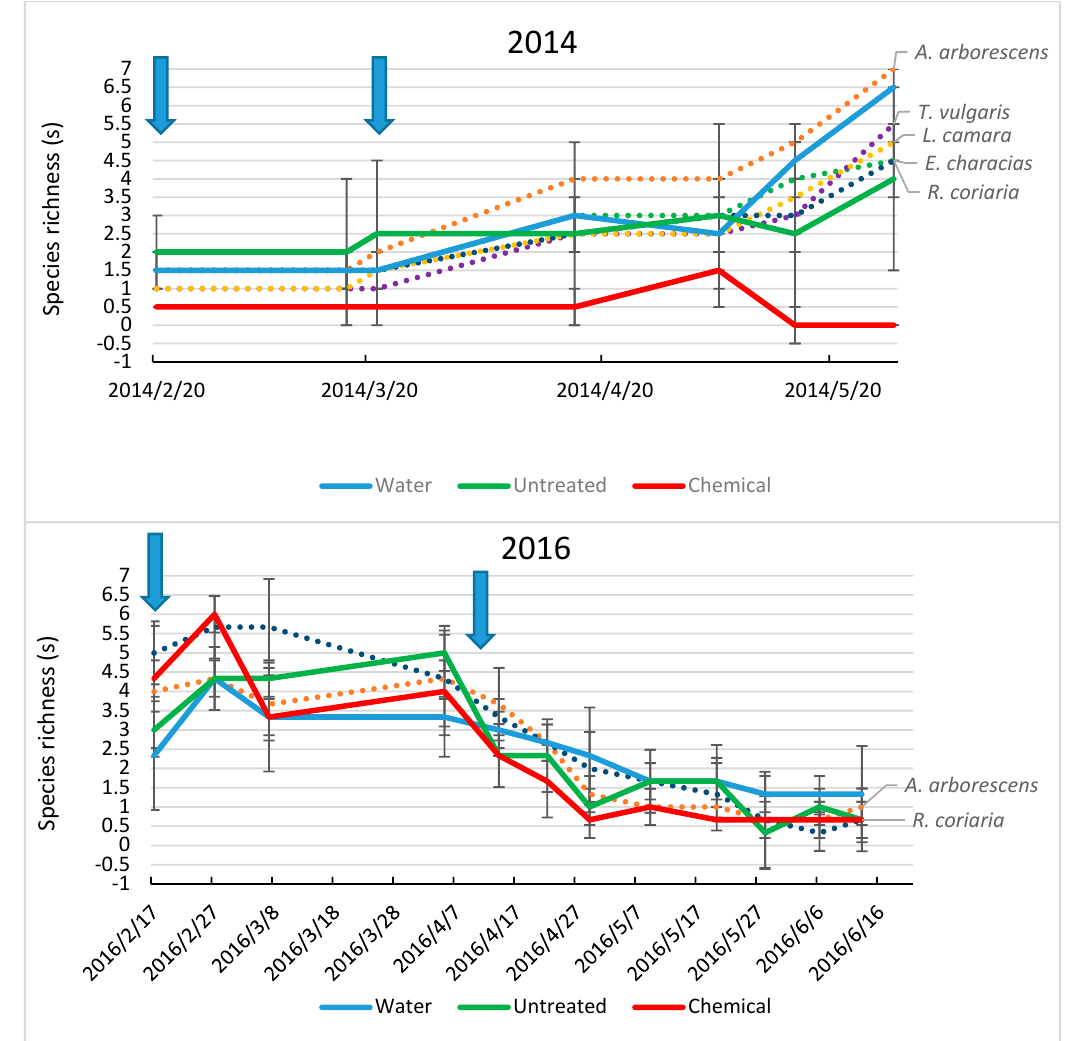
Figure 6. Species richness (n of detected weed species m − 2 ) in durum wheat treated with five (2014) and two (2016) plant water extracts, compared with an untreated control (green line), a chemical herbicide (red line), and a control with only water (blue line). Each value is the mean of three repetitions ± standard deviation. Arrows indicate the date of treatments.